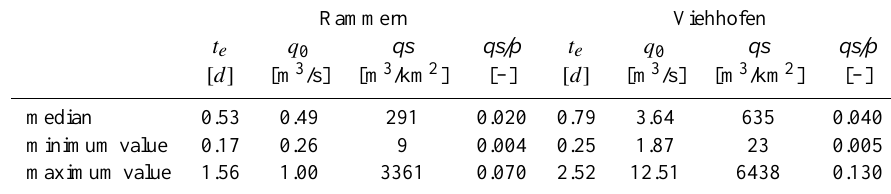
Table 5. Characteristics of the unimodal events measured at gauges Rammern and Viehhofen. Rammern Viehhofen